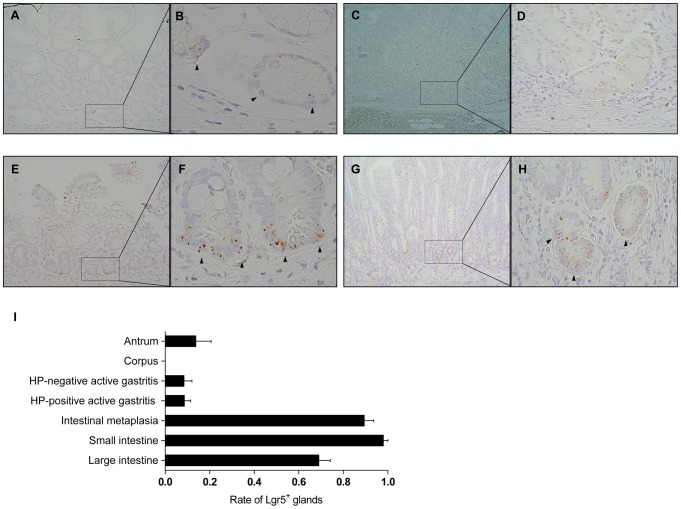
Localization of LGR5
+ cells in the gastric antrum and intestinal metaplasia.We examined many different types of non-tumorous gastric mucosa (GM), including GM without inflammation or intestinal metaplasia (IM) (antrum, n = 4; corpus, n = 4), GM with active gastritis (n = 12), and GM with IM in the antrum (n = 5), as well as small bowel (n = 5) and colon (n = 5). (A, B) Rarely, a few LGR5
+ cells were observed in the basal region of the gastric antrum. (C, D) No LGR5
+ cells were noted in the corpus. (E, F) The LGR5
+ cells population, which is located primarily in the lower regions of glands, dramatically increased in IM of the antral glands. (G, H) Interestingly, IM in the corpus had as many LGR5
+ cells as IM in the antrum. Arrows indicate the fundic glands. (E) When the ratio of LGR5
+ cell-containing glands in 20 consecutive glands was assessed, IM showed a similar ratio to the small intestine. LGR5
+ cells are indicated by arrowheads. HP, Helicobacter pylori. Magnifications: A, C, E, G, ×100; B, F, ×600; D, H, ×400.